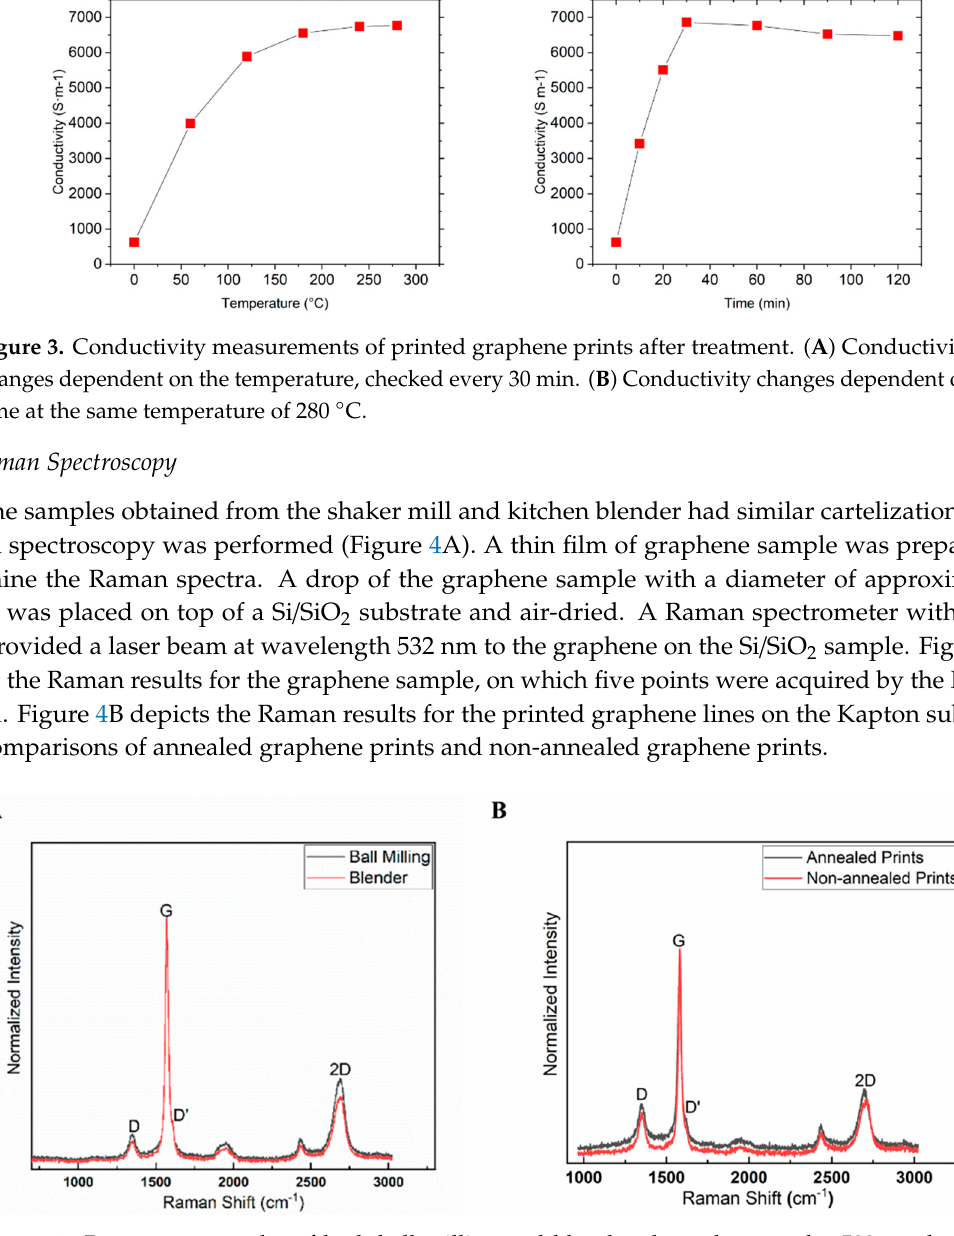
Figure 4. Raman spectra plot of both ball milling and blundered graphene under 532 nm laser. ( A ) Raman results for both ball milling and blender graphene samples on a Si / SiO 2 substrate. ( B ) Raman results for after annealed prints and non-annealed prints on Kapton tape.